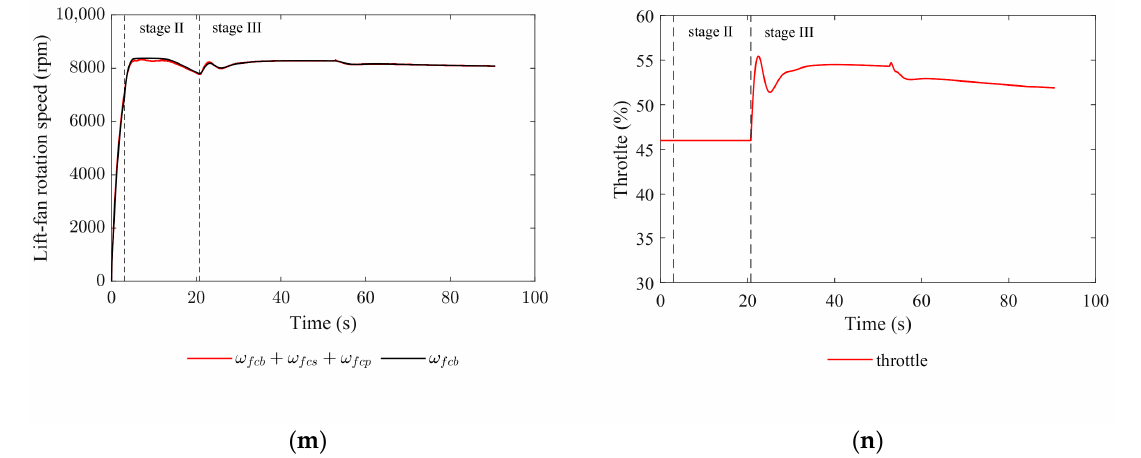
Figure 22. Nominal simulation results of short landing: ( a ) AGL (Above Ground Level)response, ( b ) angle-of-attack response, ( c ) velocity response, ( d ) roll-angle response, ( e ) sink-rate response, ( f ) roll-angular-rate response, ( g ) pitch-angle response, ( h ) side-slip-angle response, ( i ) pitch-angle-rate response, ( j ) Yaw-angle-rate response, ( k ) actuator response, ( l ) nozzle-pitch-angle response, ( m ) lift-fan-rotation-speed response, and ( n ) throttle response.